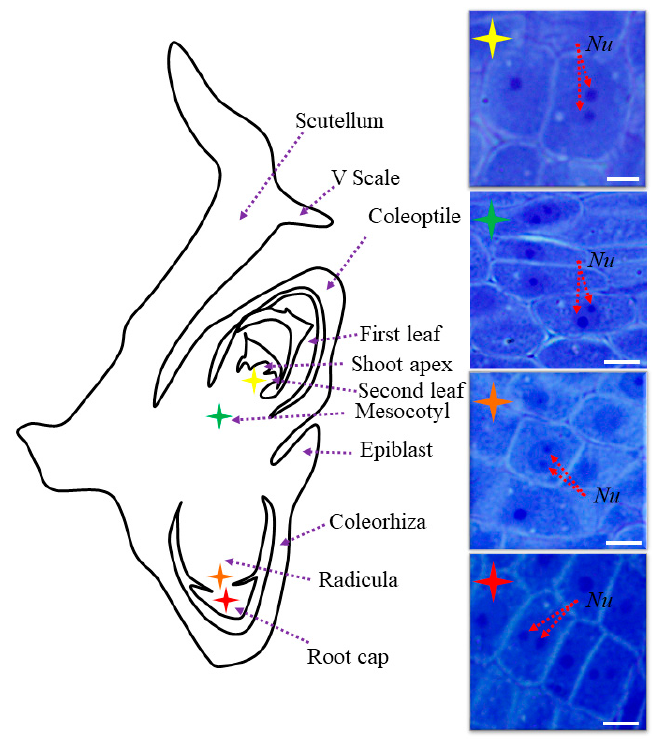
Figure 1. Schematic representation of Brachypodium embryo. Asterisks in different colours represent nuclei from histological sections of specified parts of the embryo. Red arrows mark two nucleoli. Purple arrows show respective parts of the embryo: V scale, coleoptile, first leaf, second leaf, shoot apex, mesocotyl, epiblast, coleorhiza, radicula, and root cap. Bars: 5 µm.